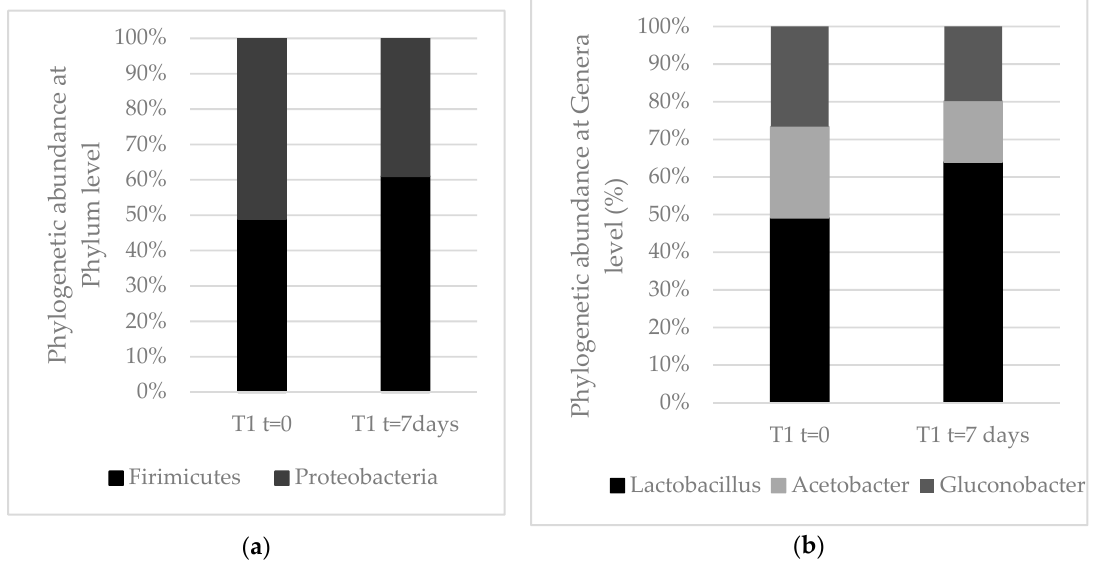
Figure 8. ( a ) Relative abundance of bacteria to Phylum level. ( b ) Relative abundance of bacteria to Genera level.